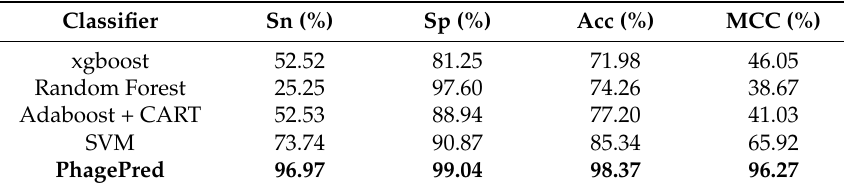
Table 1. Comparison of PhagePred with other classifiers.